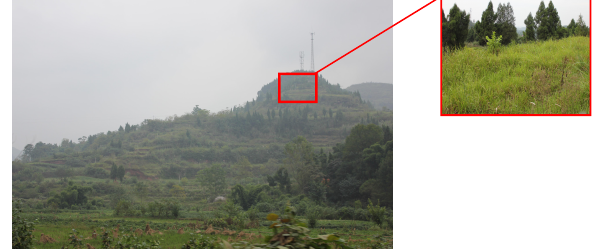
Figure 6 Geospatial distributions of conversions from cultivated land to forest in different study year